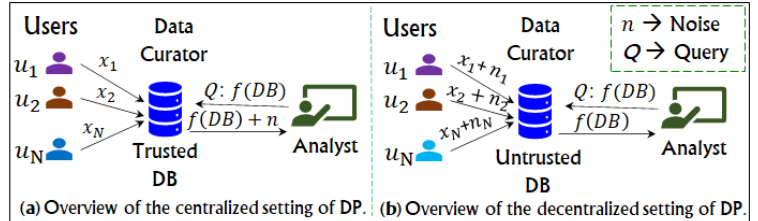
Figure 20. Overview of two famous settings of the DP